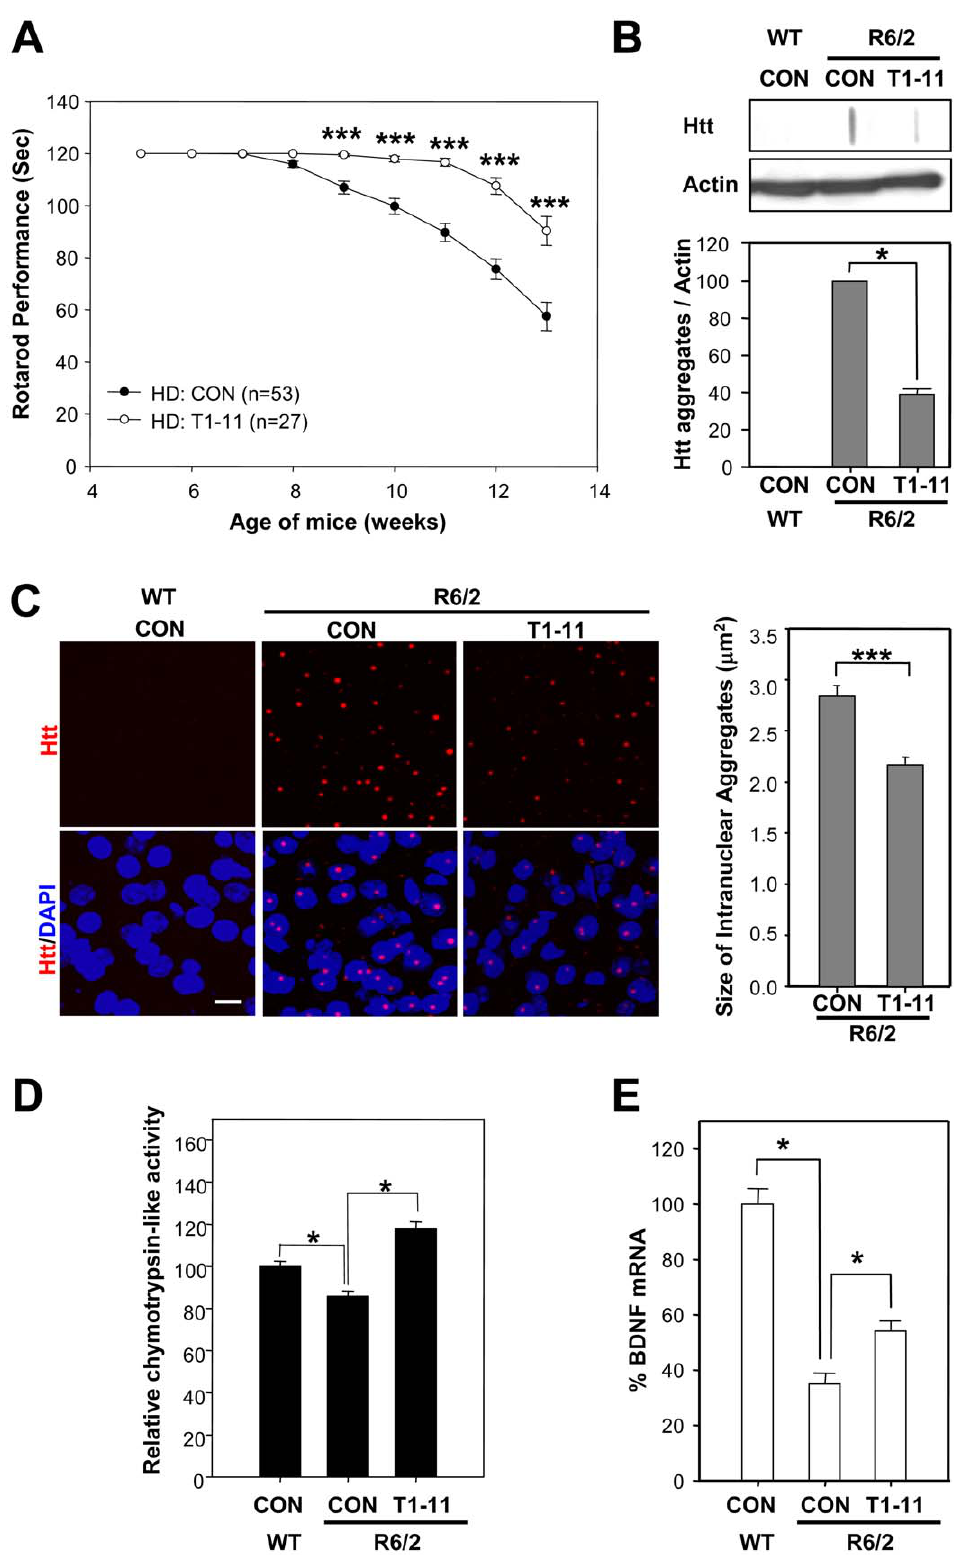
Figure 6. T1-11 exhibited beneficial effects in a mouse model of HD. R6/2 mice were given the vehicle (1% DMSO; CON, n =53) or T1-11 (0.05 mg/ml, n =27)-containing drinking water from the age of 7 weeks. (A) Rotarod performance was conducted as described in ‘‘Methods’’. (B) Striatal lysates (50 , 100 m g) collected from the indicated mice at the age of 12 weeks old were subjected to a filter retardation assay. The insoluble Htt aggregates retained on the filter were detected using an anti-Htt antibody (upper panel). The amount of protein in each corresponding lysate was independently assessed by Western blot analyses using an anti-actin antibody (middle panel). The relative aggregate formation was quantified by